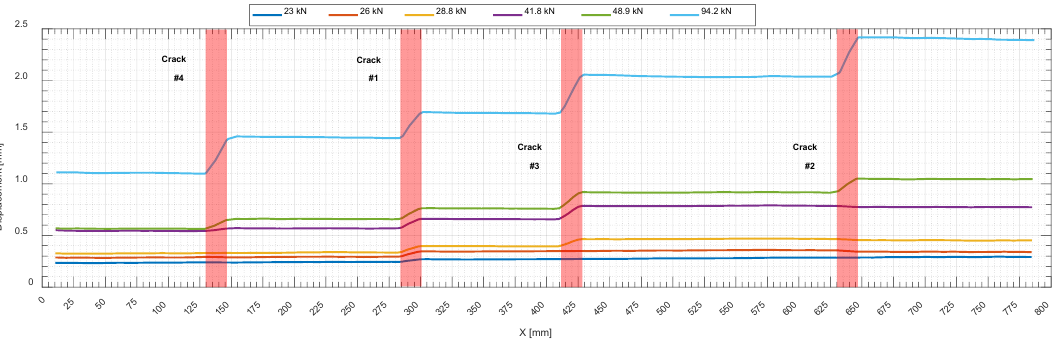
Figure 10. Surface displacement and order of crack appearance for specimen 2N100 under different loading levels.